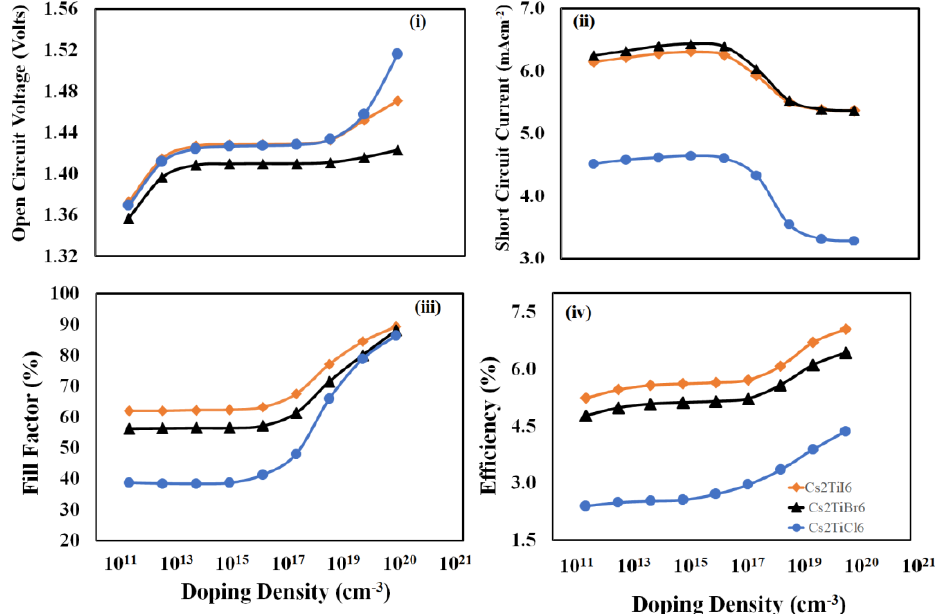
Figure 4. The photovoltaic response parameters: ( i ) open-circuit voltage, ( ii ) short-circuit current, ( iii ) fill-factor, and ( iv ) power-conversion efficiency as a function of the doping-density of PEDOT:PSS thin film (hole-transport layer) for the proposed devices Cs 2 TiCl 6 , Cs 2 TiBr 6 , and Cs 2 TiI 6 respectively.